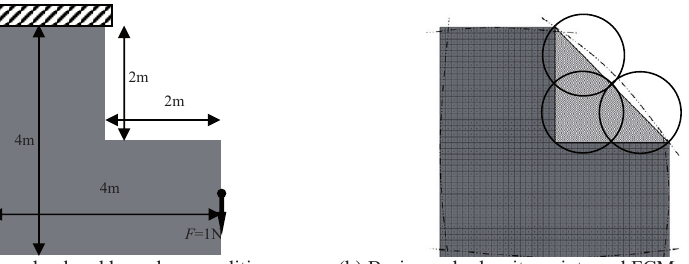
Fig. 14. Design iteration and the final configuration.